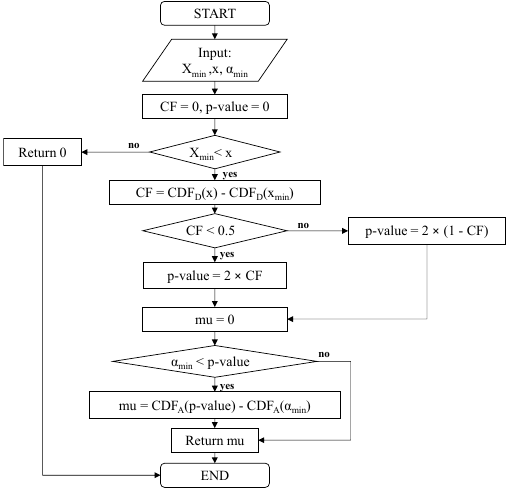
Fig. 8. Flowchart of constructing delay fuzzy